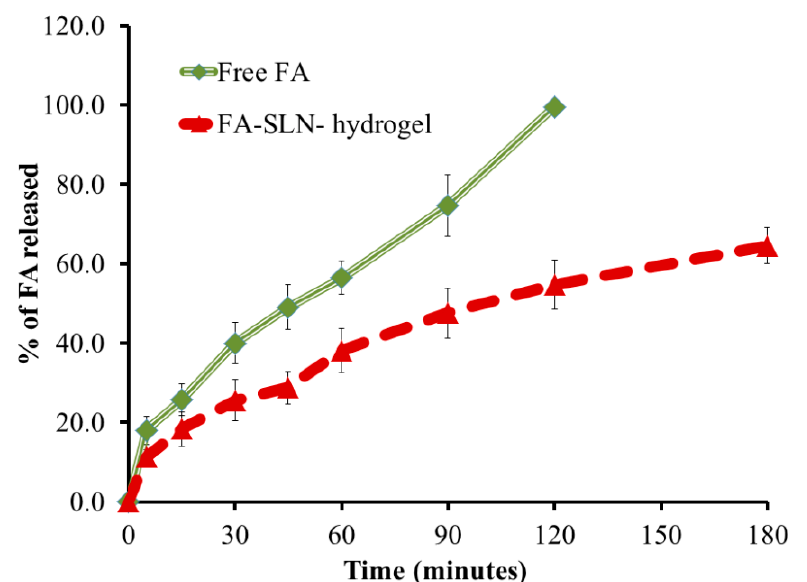
Figure 5. In vitro release study of FA from FA-SLN-hydrogel formulation using phosphate buffer saline pH 5.5 at 32 ± 0.5 °C.